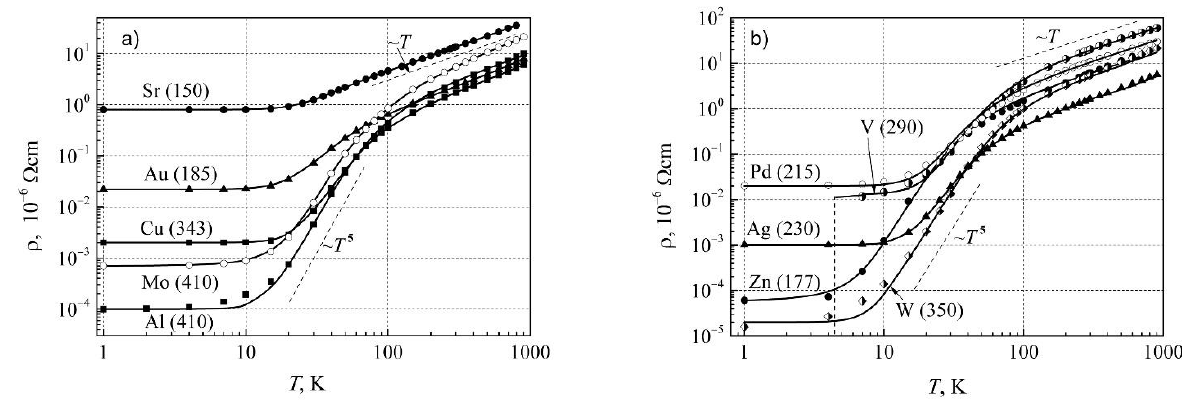
Figure 4. Electrical resistivity of Sr, Au, Cu, Mo, and Al ( a ); and Pd, V, Ag, Zn, and W ( b ) dependence on temperature (dots are experimental data [16], the solid lines are calculation results by Equation (20); in brackets near the metal chemical sign there is the Debye′s temperature in K used for calculation).